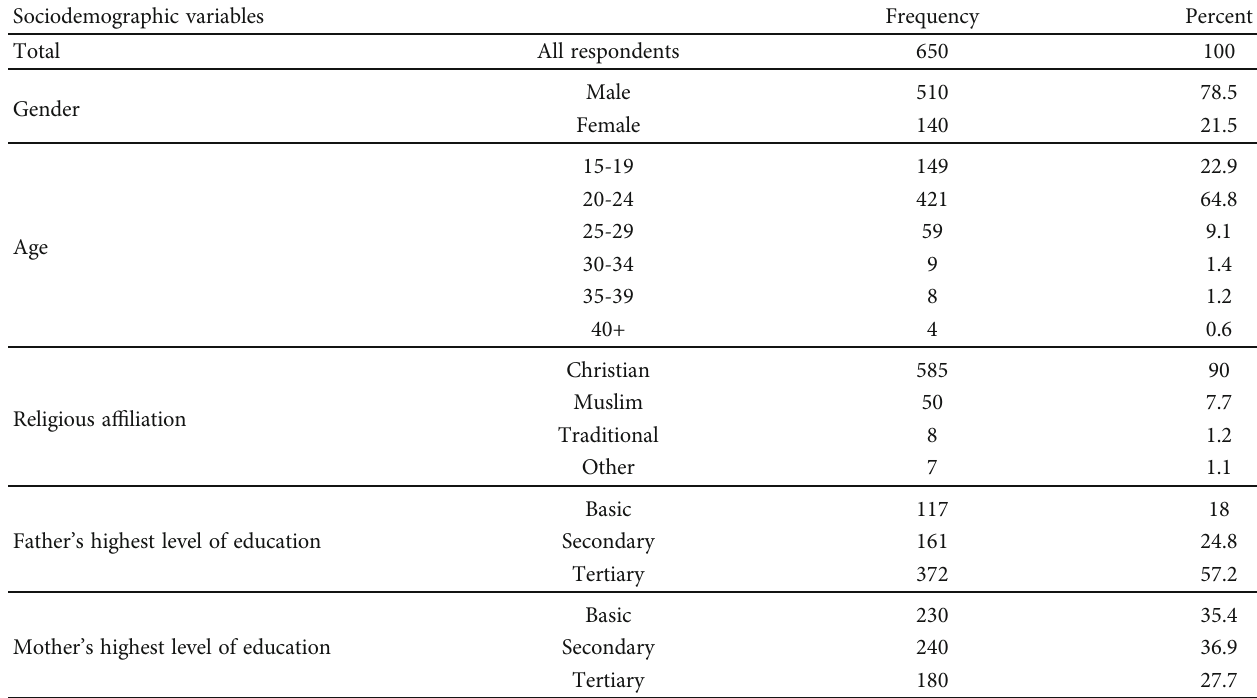
Table 1: Sociodemographic pro fi le of the respondents.